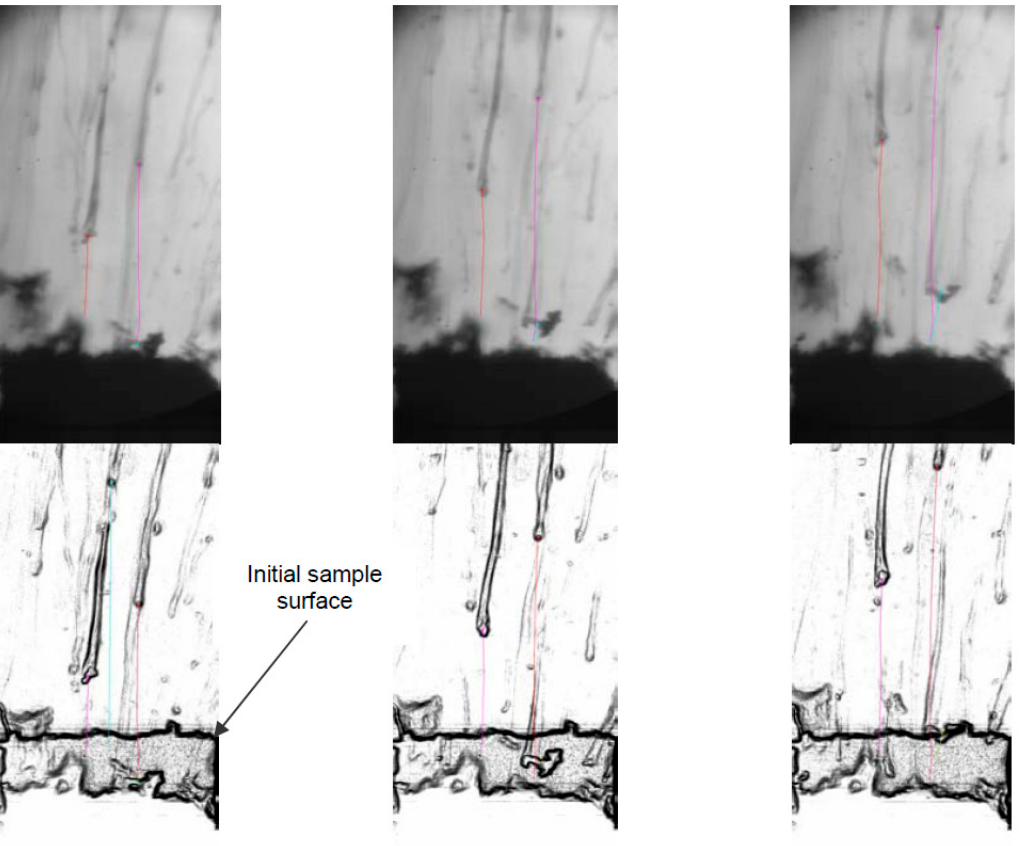
Figure 23. Particle tracking without and with FST: processing of acquired images (top) and post- processed images (bottom). Reprinted with permission from Ref. [42] (2022).